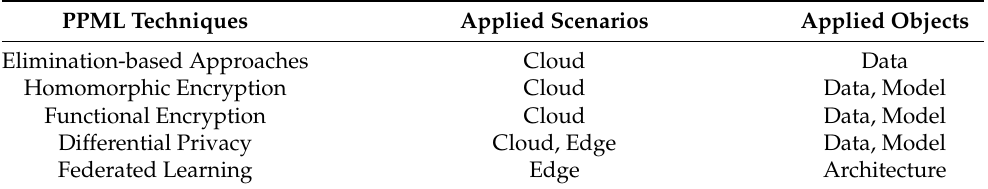
Table 3. Privacy-preserving machine learning techniques and their usages. Data: data preparation and storage, model: model training and inference, architecture: deep model